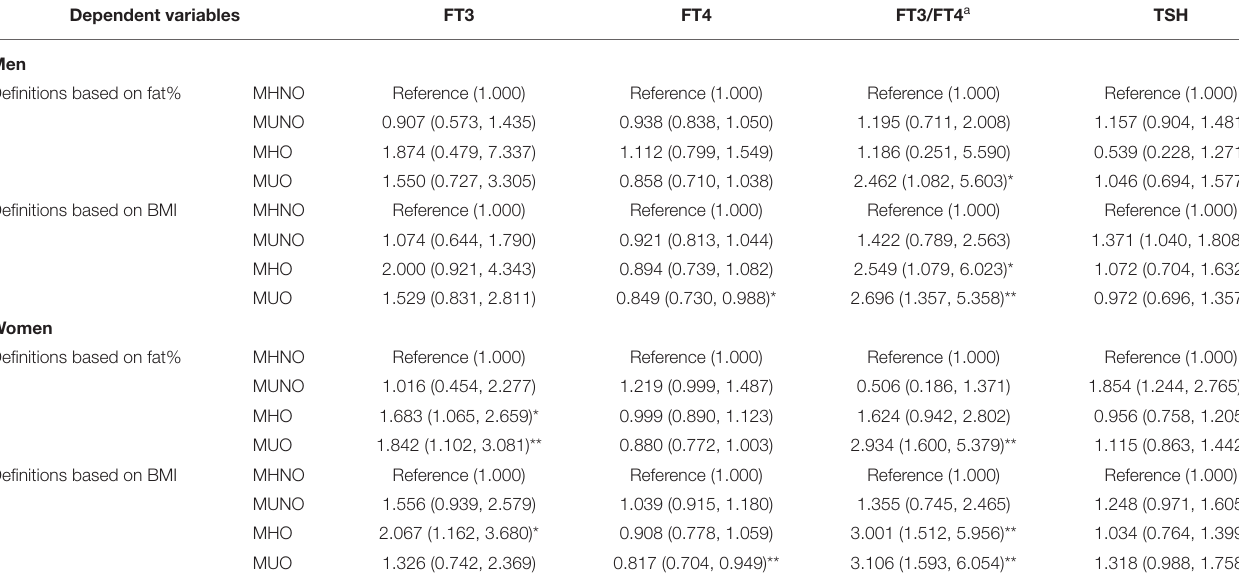
TABLE 3 | Subgroup analysis on the gender